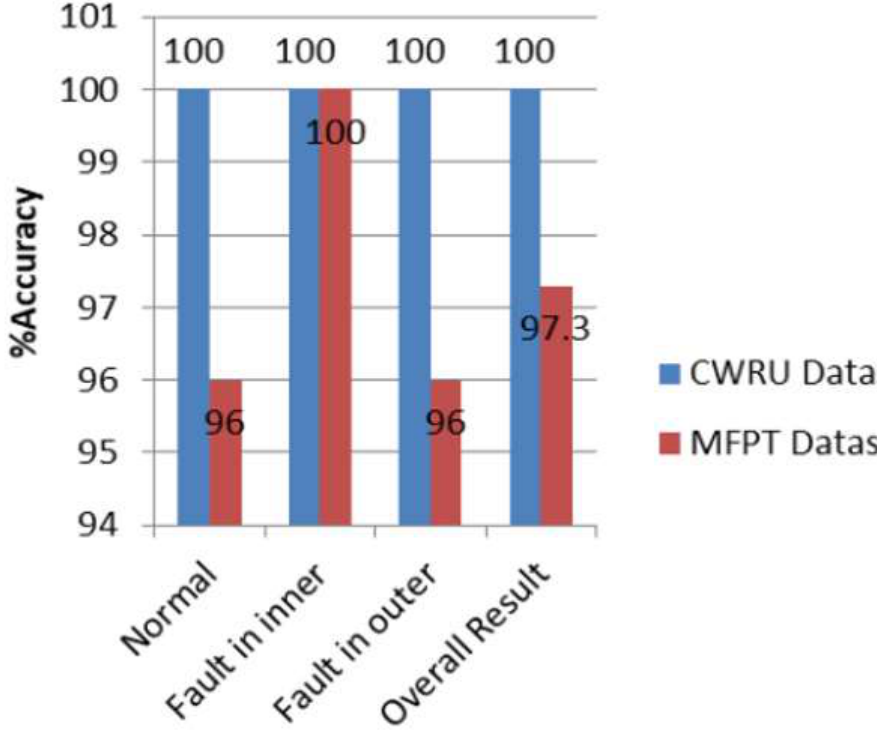
Figure 11. Performance of CWRU vs. MFPT dataset.